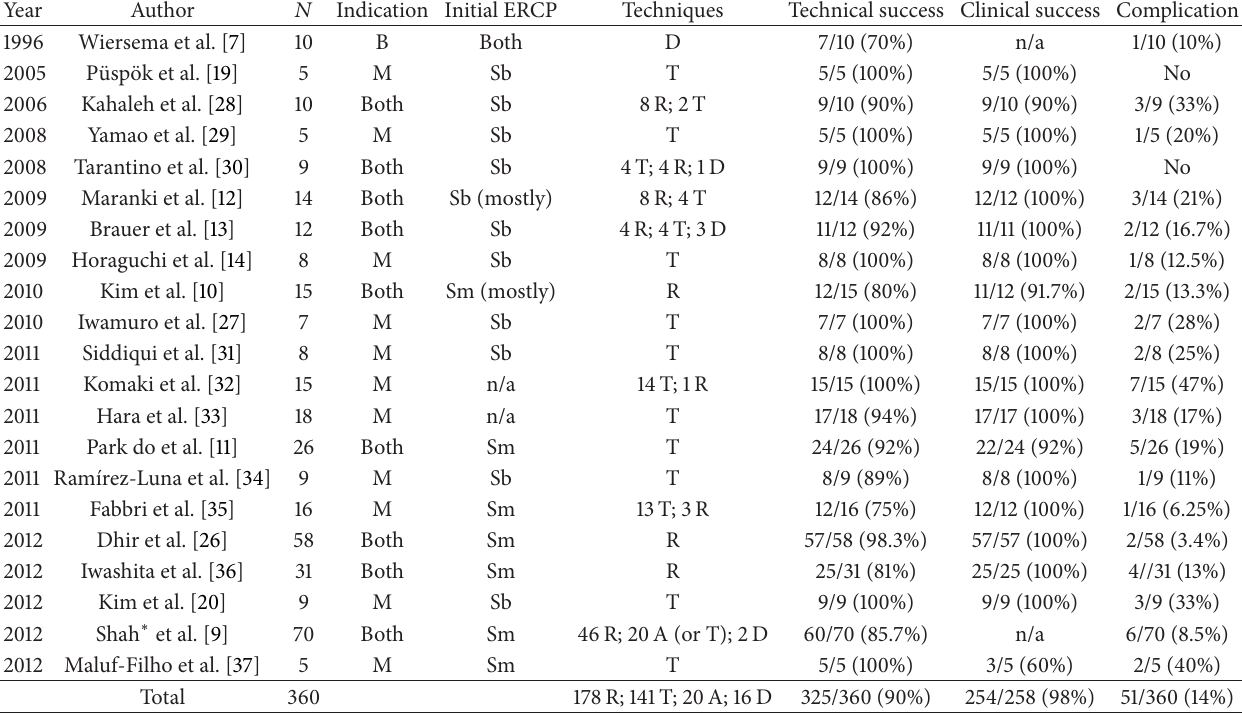
Table 2: Published EUS-CP series on Extrahepatic biliary tree drainage (involving ≥ 5 patients).